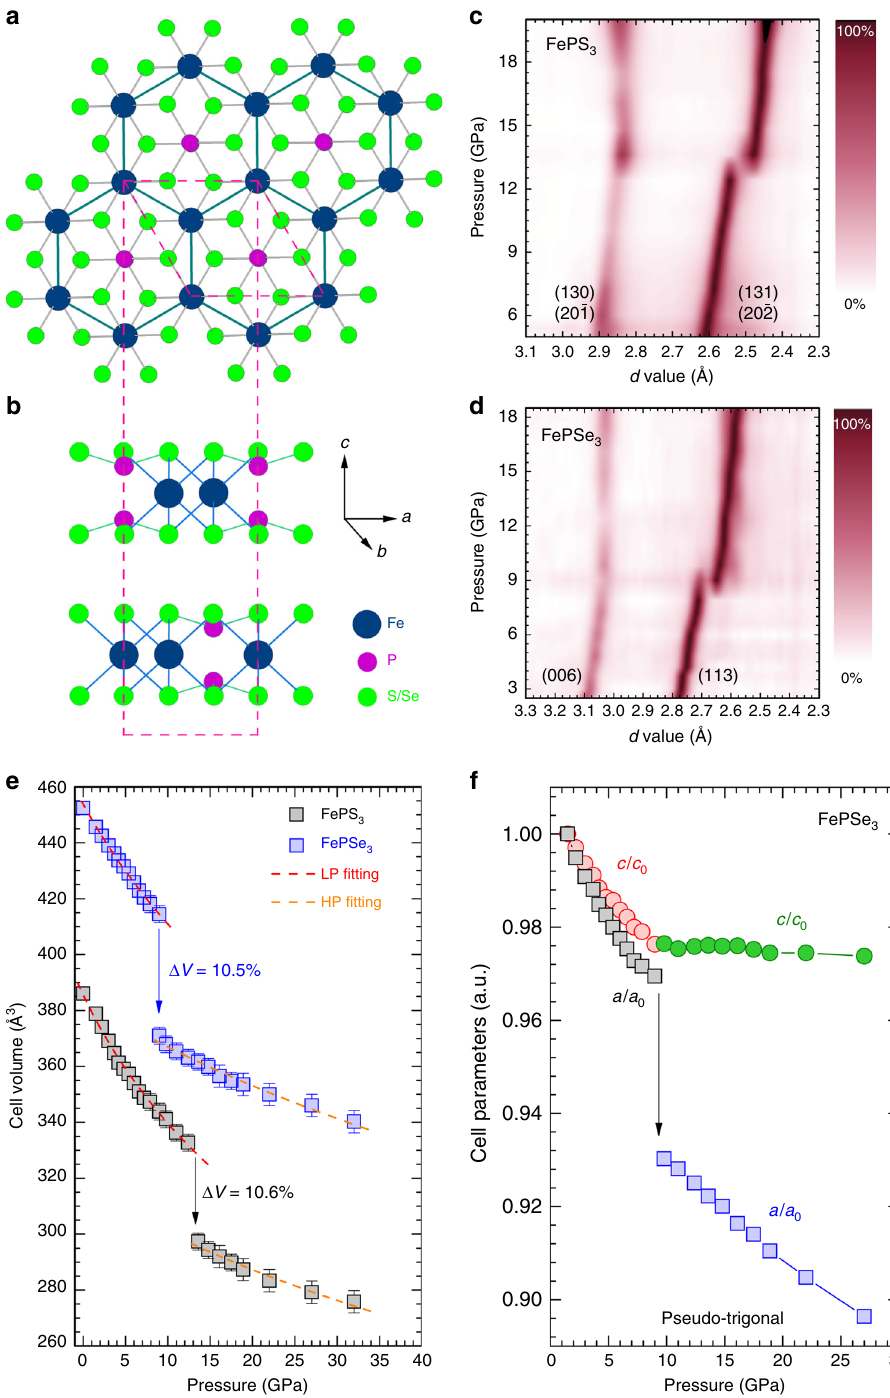
Fig. 1 The crystal structure and pressure-induced phase transition of FeP X 3 . a , b Ambient crystal structure of FeP X 3 ( X = S, Se) viewed along c - and a / b - axis showing the layered structure feature and the Fe 2 + honeycomb lattice. c , d Two-dimensional PXRD data showing abrupt pressure-induced changes of the (131) and (20-2) peaks for FePS 3 and the (113) peak for FePSe 3 , respectively. e The derived cell volume values as a function of applied pressure for the LP and HP phases of FePS 3 and FePSe 3 . The derived bulk moduli are: B 0 = 61.1(2) and 162(9) GPa for LP and HP FePS 3 ; B 0 = 82.8(7) and 201(8) GPa for LP and HP FePSe 3 , respectively. Error bars represent ± S.D. f The cell parameters of FePSe 3 with a pseudo-trigonal unit cell showing an in-plane collapse along with the pressure-induced phase partially fi lled 3 d shell electrons. Therefore, it allows qualitative the K β ′ peaks drop suddenly and the K β 1,3 lines shift to lower distinction of the HS/LS states from the relative intensities of energy correspondingly, both of which indicate the occurrence of satellite K β ′ and the peak positions of K β 1,3 . In the LP phases of SCO of Fe 2 + within the honeycomb lattice. FeP X 3 , well-de fi ned K β ′ satellite peaks are observed with a HS state ( S = 2). Concomitant with the structural phase transition,